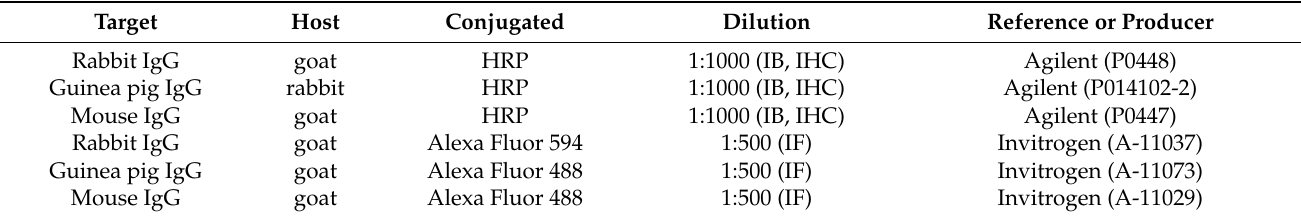
Table 2. List of conjugated